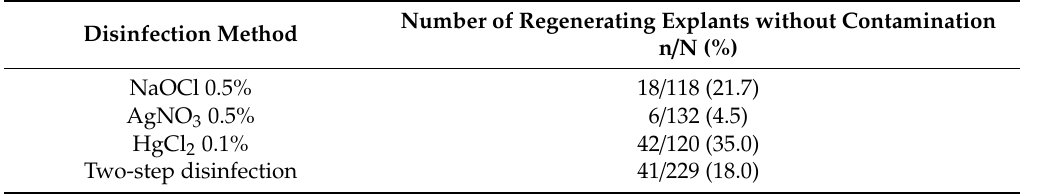
Table 2. Disinfection e ffi ciency and regeneration rate of S. lapponum explants depending on the disinfection